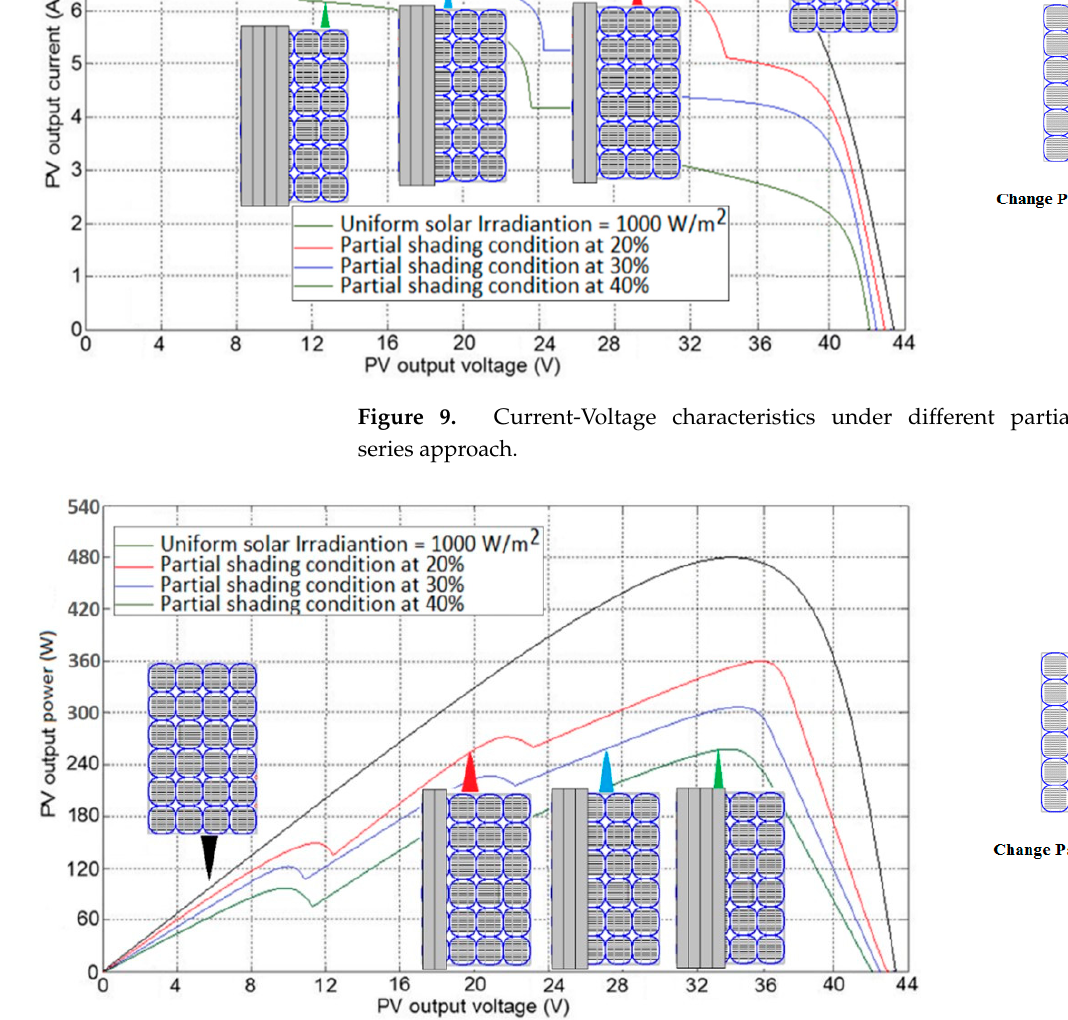
Figure 10. Power-Voltage (power characteristics) under different partial shading conditions for series approach.